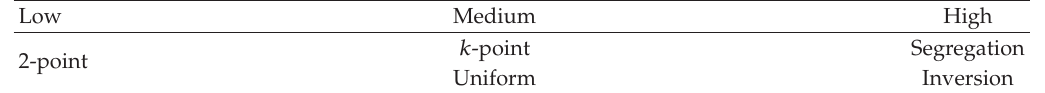
Table 5: Levels of crossover operator based on